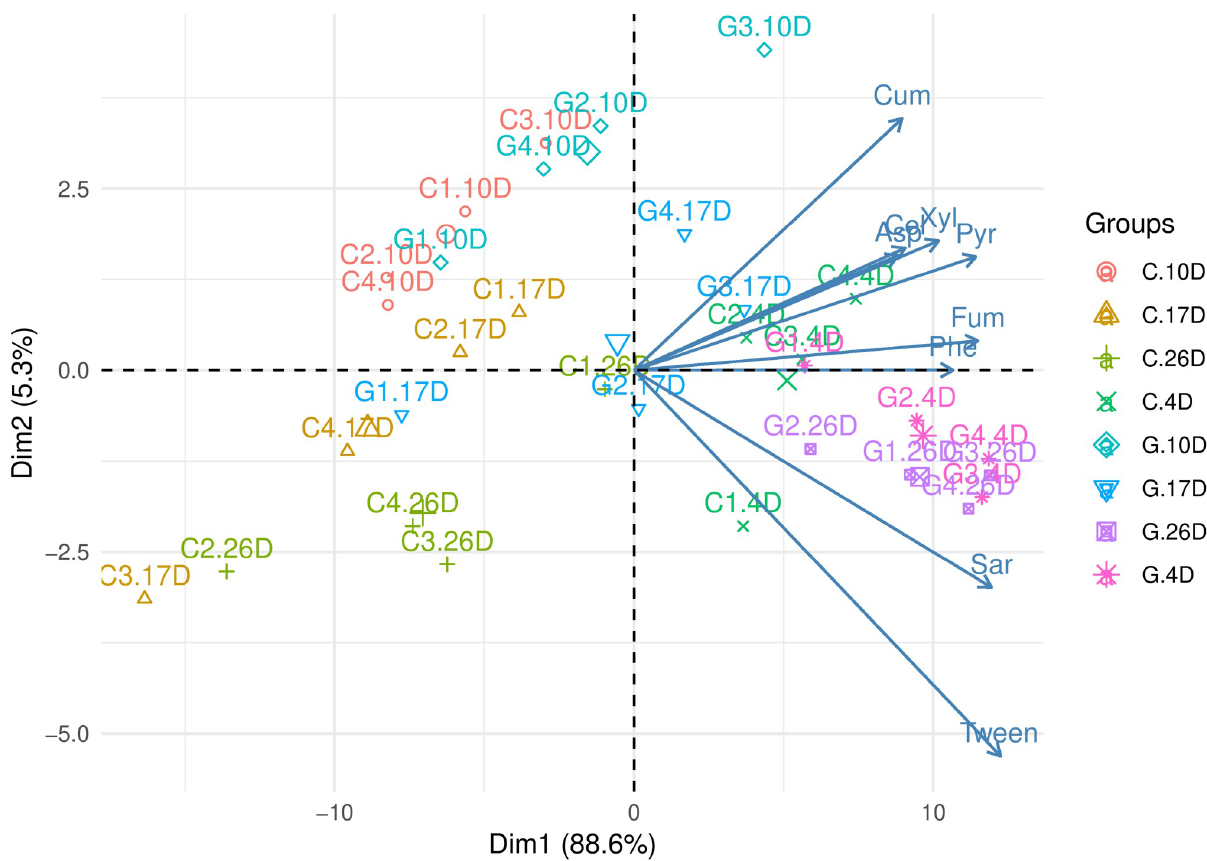
Fig 1. Principal component analysis (PCA) biplot of catabolic profiles. Variables are indicated in blue vectors while observations are represented by different colours and symbols according to the treatment (legend “ Groups ”). Letter C indicates mowing suppression and letter G glyphosate suppression. The number after these letters indicates the replicate, while the number after the point indicates the sampling time (.4D: 4 days; .10D: 10 days; .17D: 17 days; .26D: 26 days).